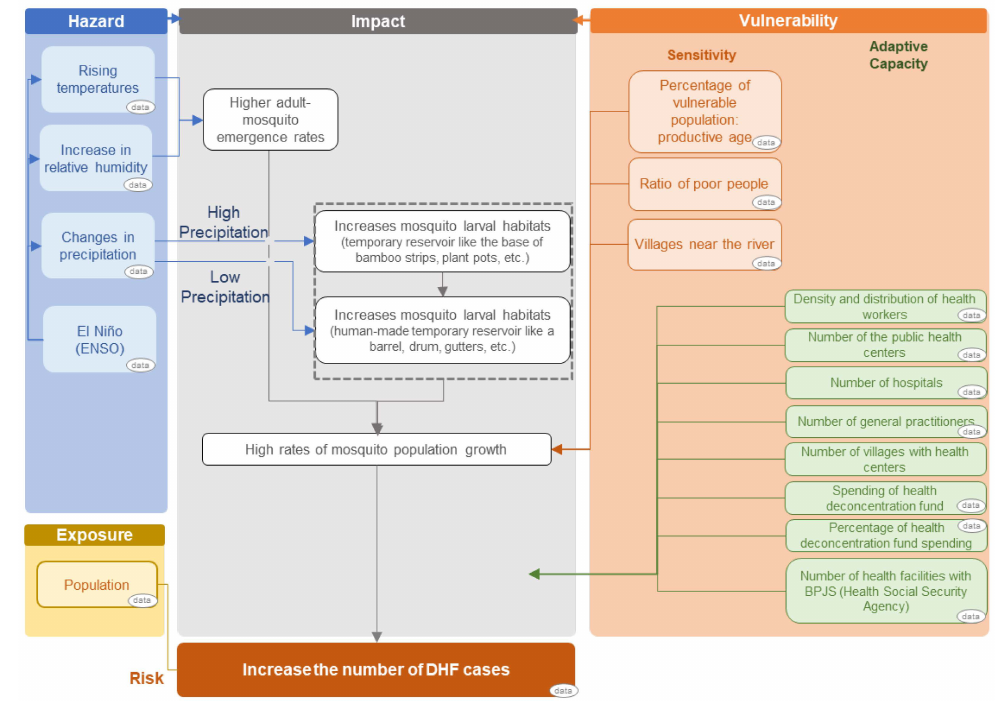
Figure 1. Results of climate change impact chain of the dengue number of